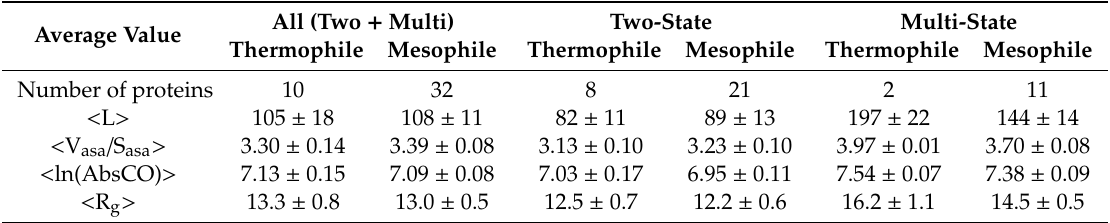
Figure 7. Schematic “chevron” plots of the constant of observed rate ( kapp = kf + ku ) versus temperature for thermophilic and mesophilic proteins. Table 7. Average values of structural parameters for two-state and multi-state thermophilic and mesophilic proteins.